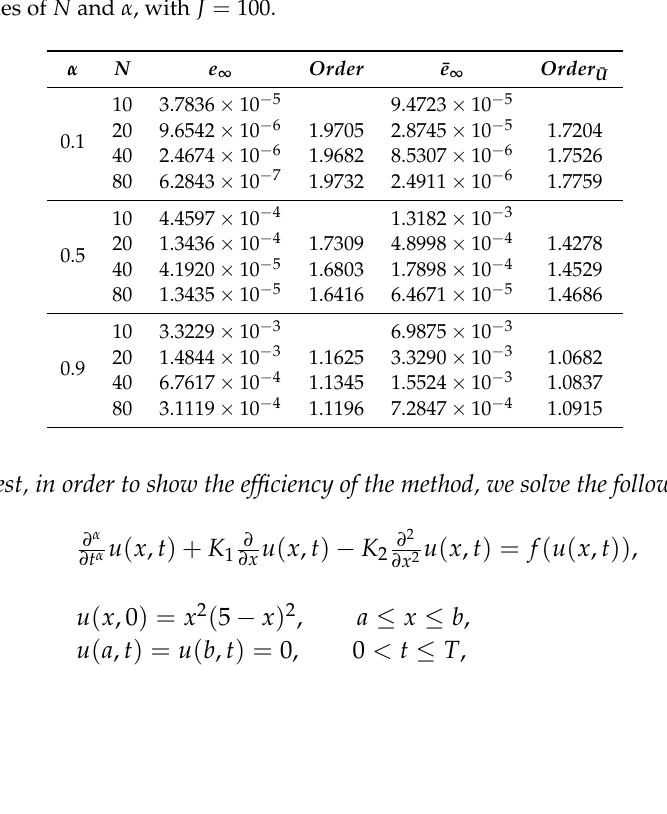
and ¯ U n , respectively, j j